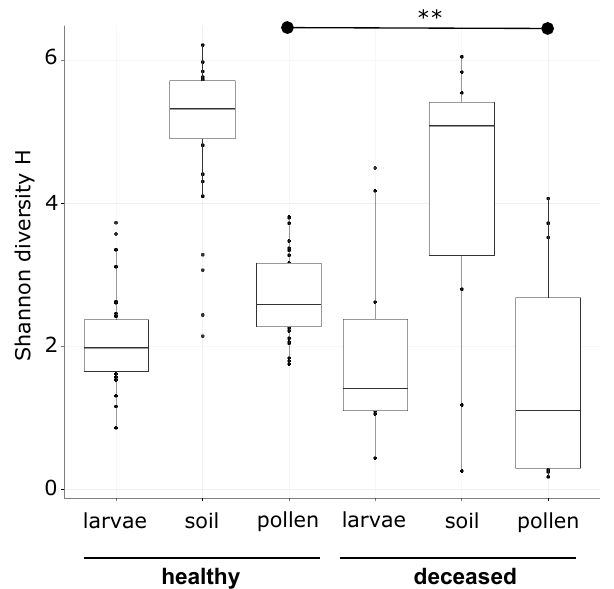
Figure 1. Shannon diversity of bacterial taxa found in larvae, pollen and soil from 31 nest chambers with healthy Osmia bicornis larvae and 12 nest chambers with deceased O. bicornis larvae.